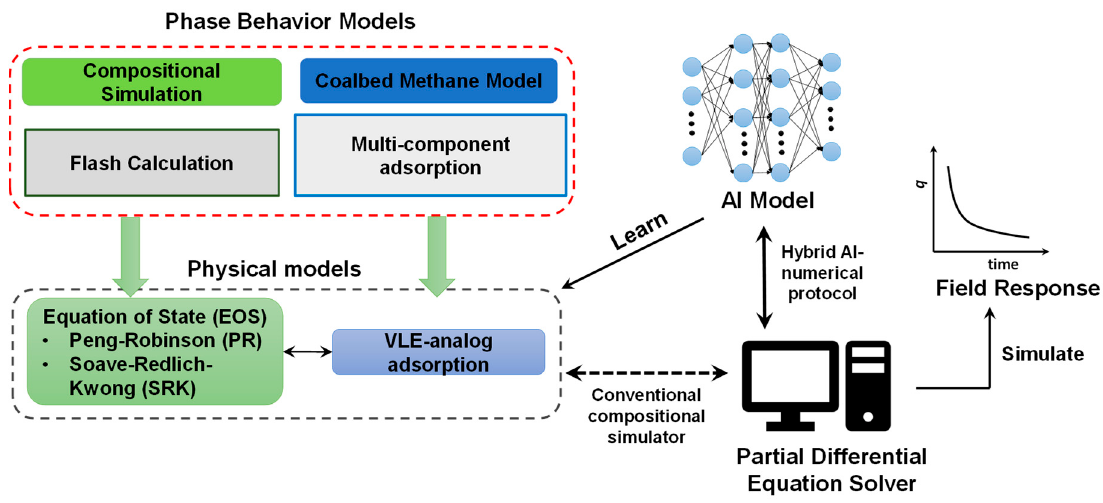
Figure 12. Illustration of the AI-numerical hybrid compositional simulation protocol.